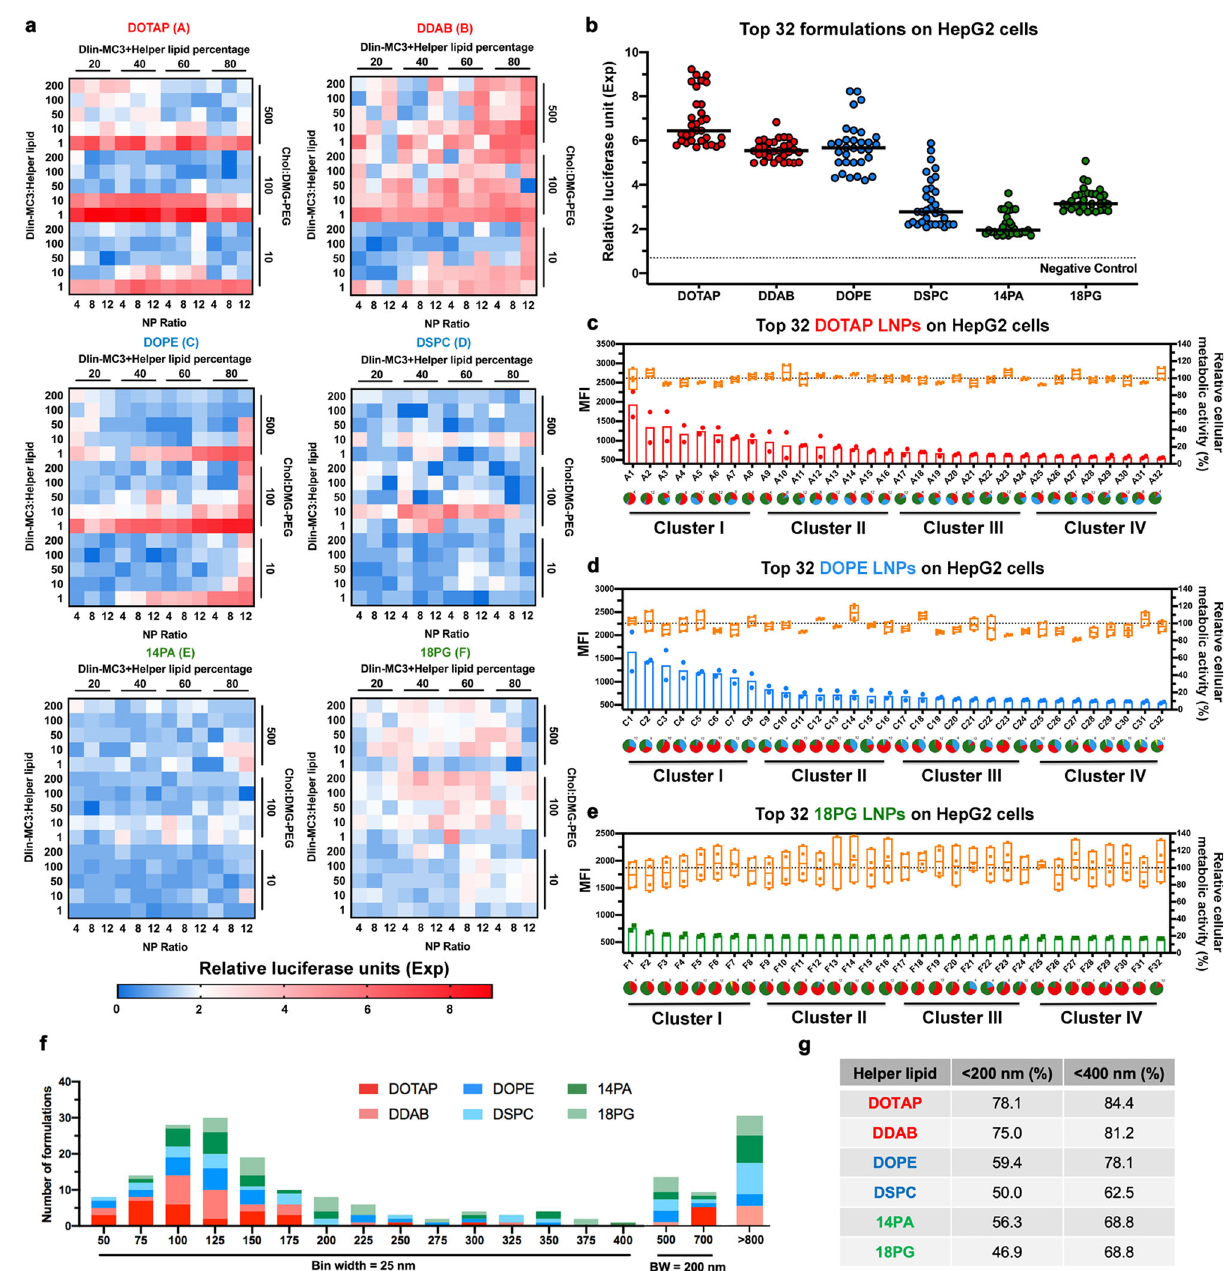
Fig.2|InvitroLNP-mediatedpDNAdelivery.a Transfectionef fi ciencyofLNPsin HepG2 cells via high-throughput screening platform after 72h incubation ( n =2). Theleveloftransgeneexpressionforeachformulationisshownusingluciferaseas a reporter. b The top 32 formulations from each helper lipid series were selected based on transfection ef fi ciency in HepG2. FACS was used to further evaluate the reporter gene at a pDNA dose of 1 μ g/mL; gene expression was analyzed at 72h after transfection ( n =2). Cellular metabolic activity was measured by alamarBlue assay( n =4).Formulationswereregroupedintofourclusters,eachcontainingeight